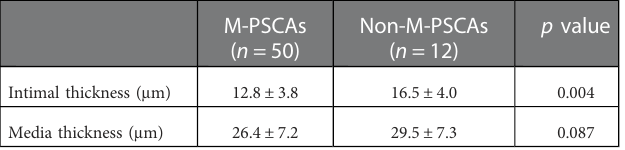
TABLE 5 Intimal and media thickness of middle cerebral arteries between M-PSCAs and non-M-PSCAs in moyamoya diseasea.